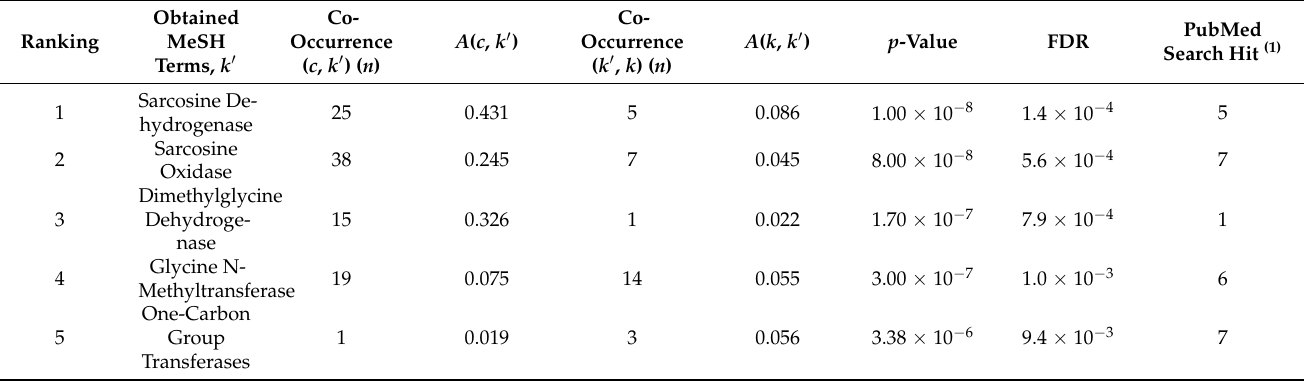
Table 2. Medical Subject Heading (MeSH) terms ( k (cid:48) ) obtained from sarcosine (metabolite, c ) and prostate neoplasm (the researcher’s known keyword, k ) using the confidence (LR) method at a false discovery rate (FDR) level of